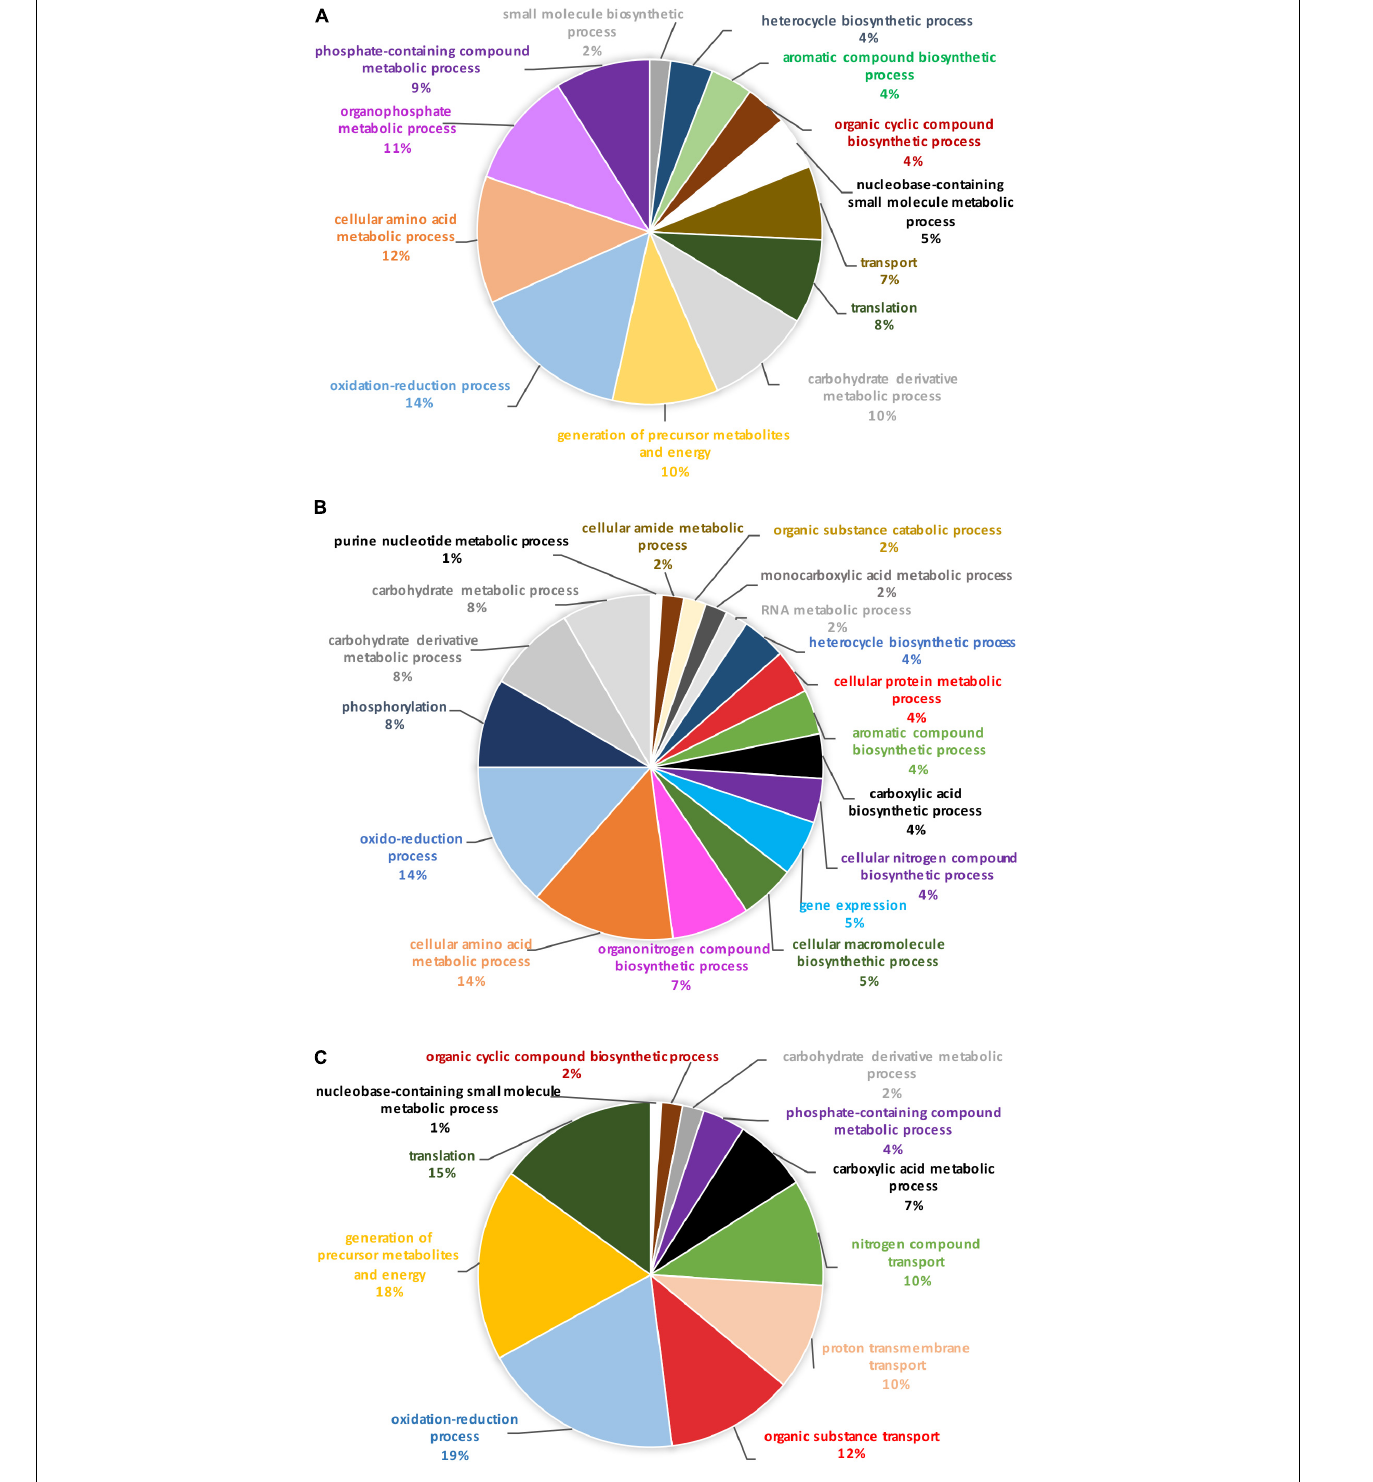
FIGURE 6 | Pie chart representing the biological process in which the 648 proteins, unique to the oval morphotype are involved. (A) Overall biological processes associated with the overall specific expressed proteins in the oval morphotype. (B) Biological processes which are associated with the up-regulated proteins. (C) Biological processes associated with down-regulated